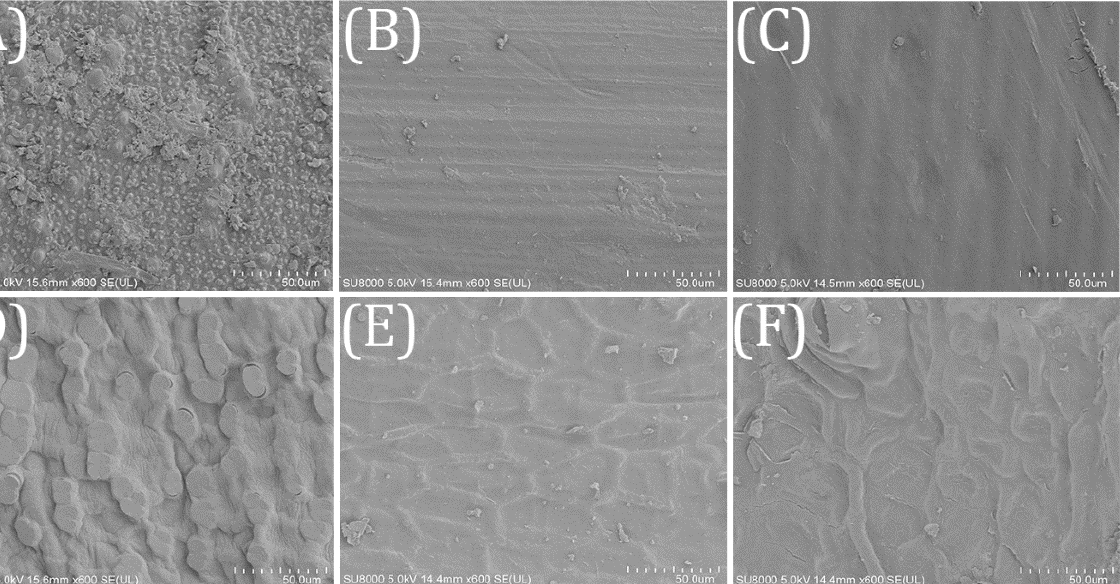
Figure 1. Cellulosic components of the investigated agricultural wastes.